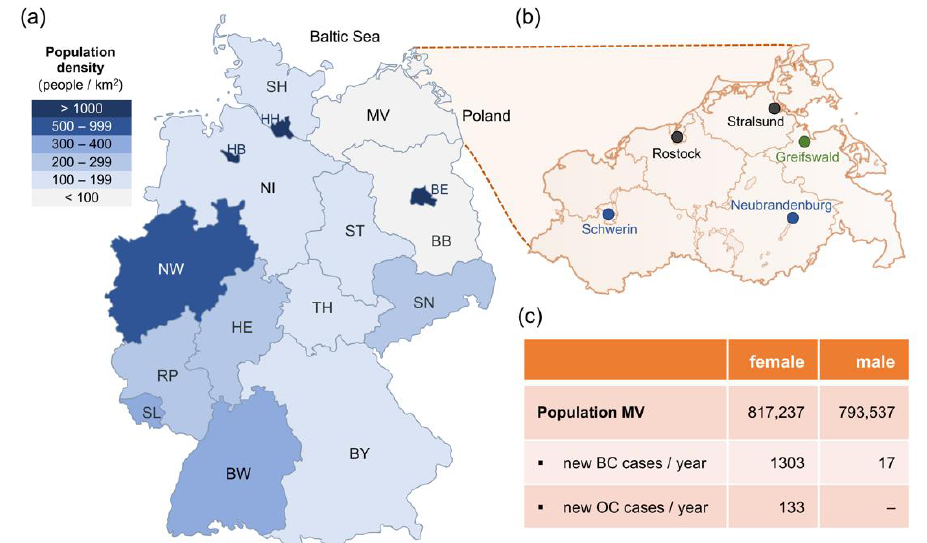
Figure 2. Geographical location of the Familial Breast and Ovarian Cancer Center Greifswald. ( a ) Population density in the 16 federal states of Germany in people per square kilometer (people/km 2 ) [12], ( b ) Mecklenburg-Western Pomerania (MV) with its five largest cities. The Familial Breast and Ovarian Cancer Center Greifswald and its cooperation partners are marked in green and blue, respectively. Attribution for the map [13]. ( c ) Population and BC/OC statistics for Mecklenburg-West-